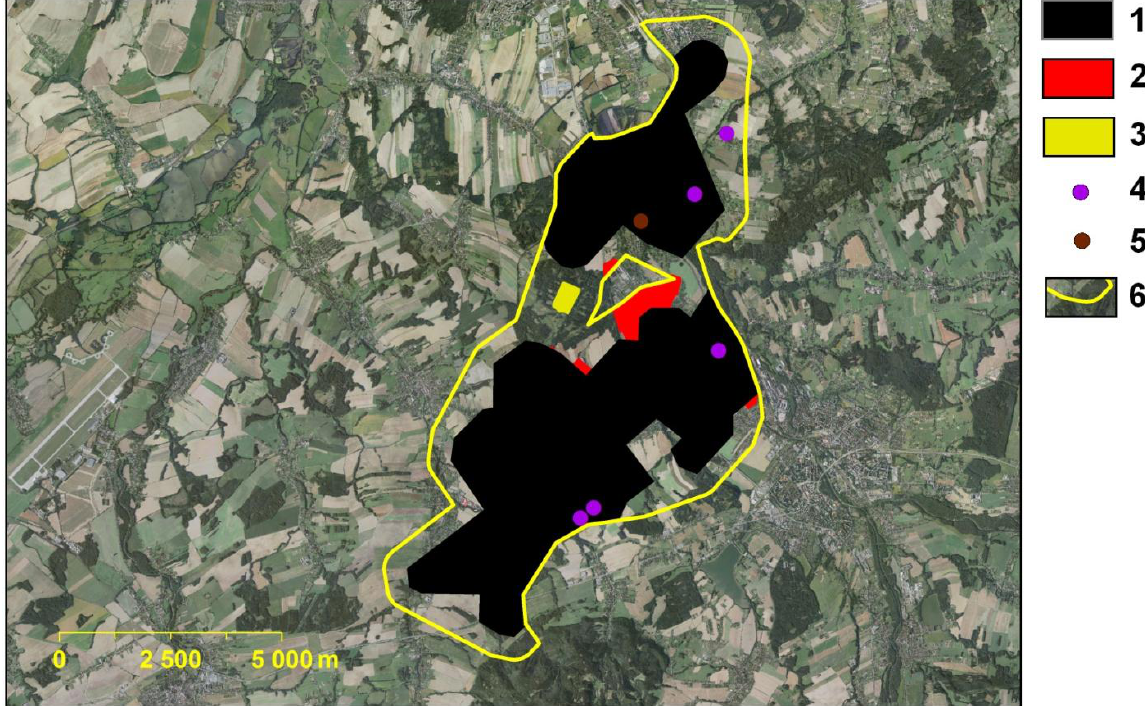
Fig. 9. Example of cartographic documentation of the identified post-industrial landscapes on the example of the Paskov region 1 – mining and undermined areas; 2 – industrial sites with brown fields; 3 – disposal sites; 4 – contaminated sites; 5 – brown fields; 6 – boundary of post-industrial landscape generated by GIS (The base: colour orthophoto from the CENIA database. Data sources: CENIA, Czech Geological Survey, CORINE LC 2006, CzechInvest, ČÚZaK,